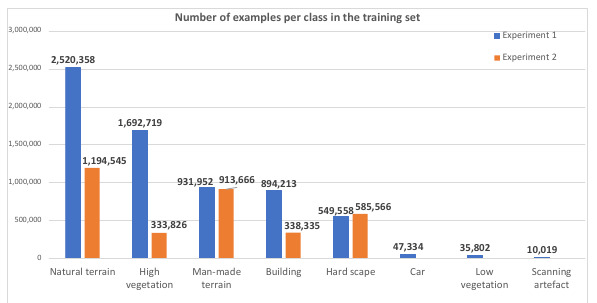
Figure 1. Histogram showing the number of examples in the training set